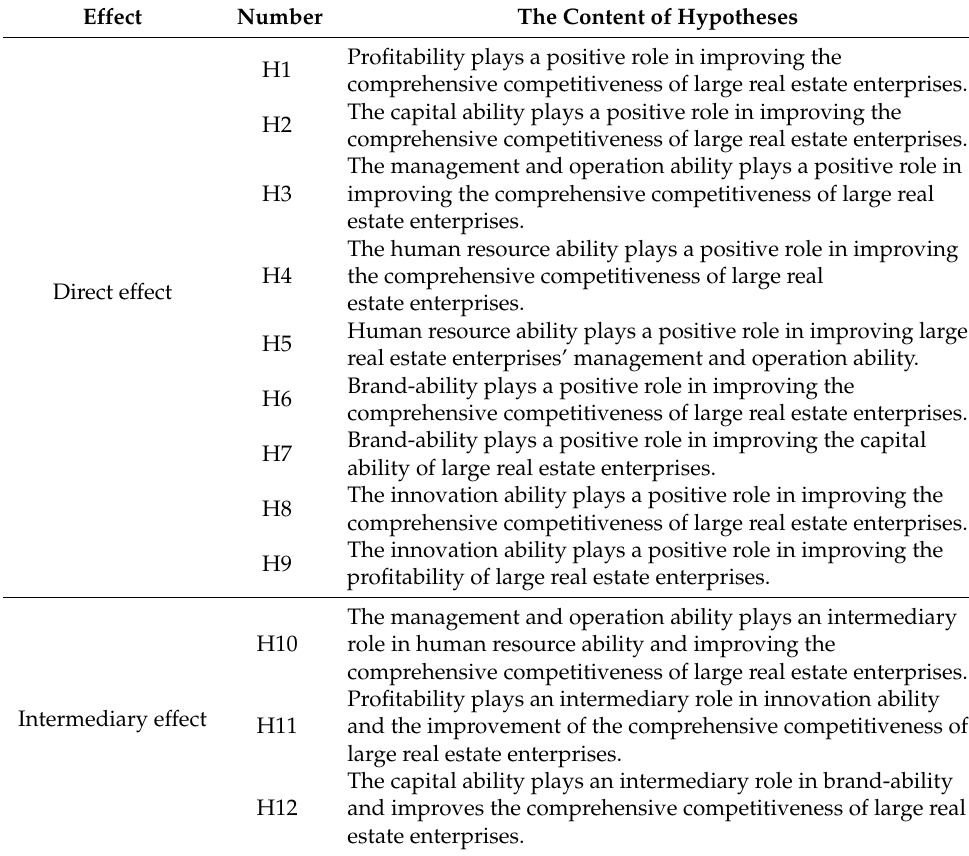
Table 2. The summary of research